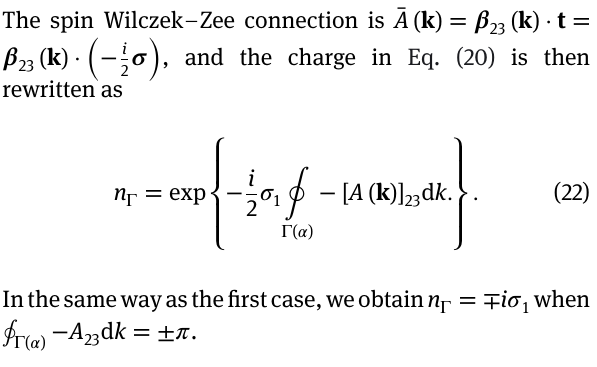
[ ] 𝜎 , 𝜎 , 𝜎 are the Pauli 1 2 3